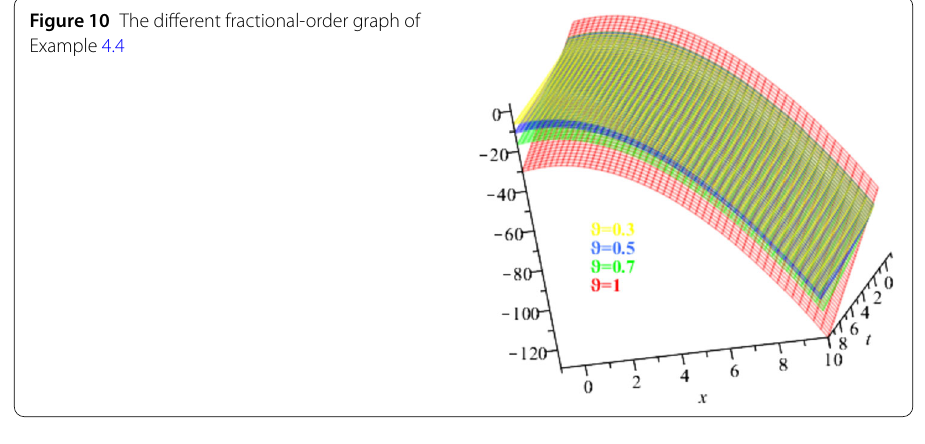
Figure 11 The NAAM and fractional-order solution graphs of Example